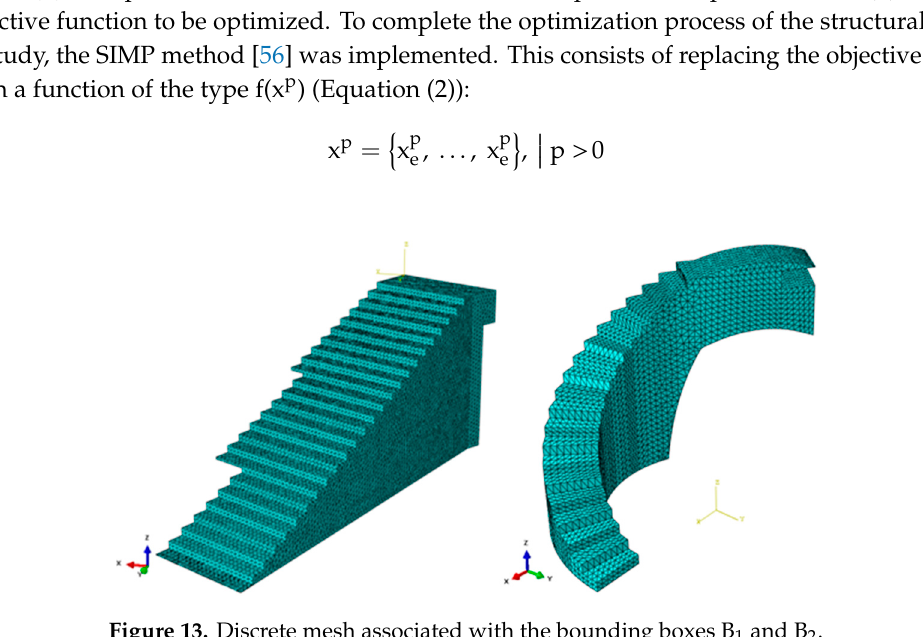
Figure 13. Discrete mesh associated with the bounding boxes B 1 and B 2 . Table 6. Statistics of the discrete mesh associated with the bounding boxes B 1 and B 2 .